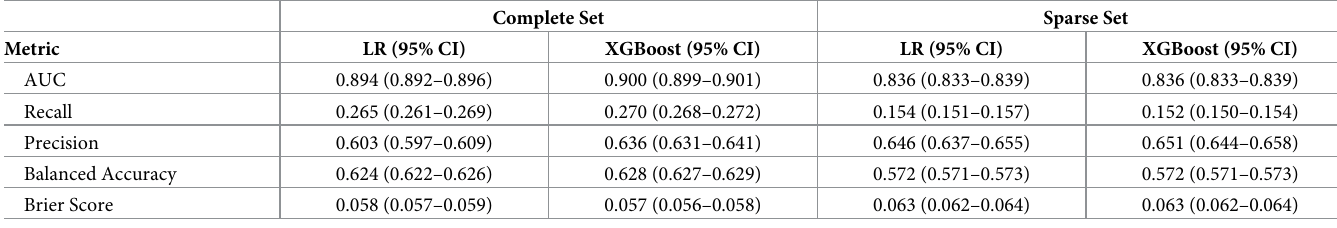
Table 3. Performance metrics for logistic regression and machine learning based models.